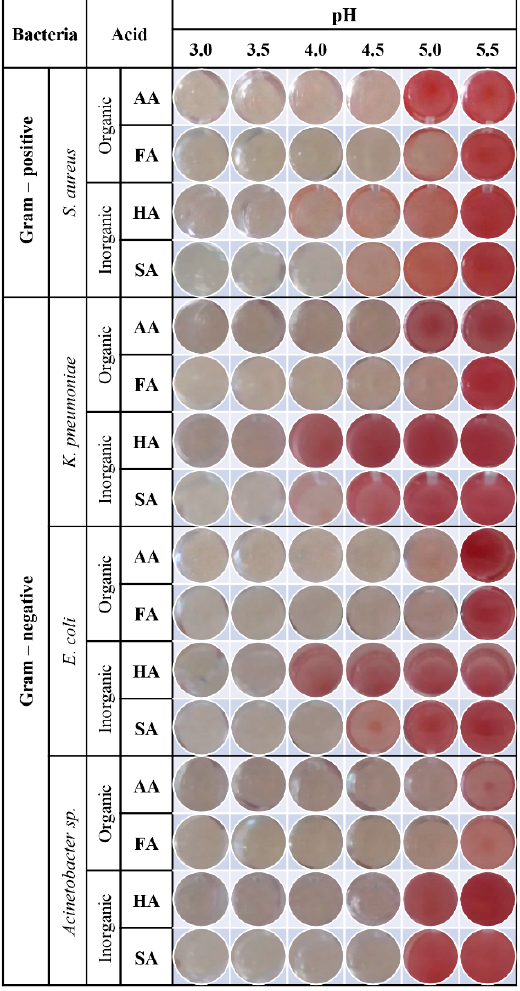
Figure 1. Differences between Gram-positive and Gram-negative bacterial growth in pH-adjusted MHB medium, assessed with the iodonitrotetrazolium chloride (INT) assay) [17]. Wells where bacterial growth occurred show a pink colour. The pH gradients shown were obtained with the addition of organic (AA and FA) and inorganic (HA and SA) acids. For simplification, a representative well for each bacteria species is shown out of the triplicates done in the same assay. Each assay was repeated twice on different days. The conditions above pH 5.5 did not affect bacterial growth and for simplification, they are not shown. Legend: AA–acetic acid, FA–formic acid, HA–hydrochloric acid, SA–sulphuric acid.